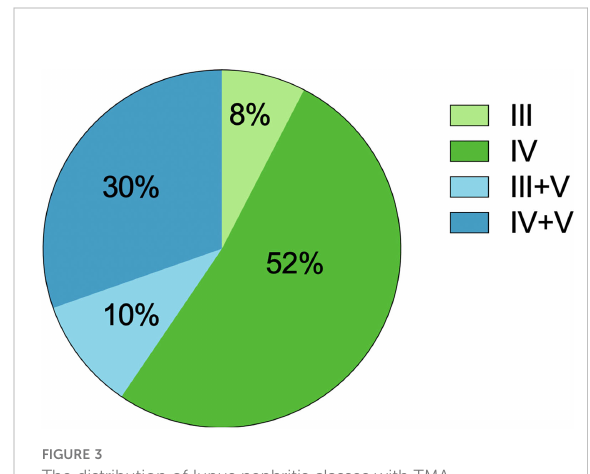
FIGURE 3 The distribution of lupus nephritis classes with